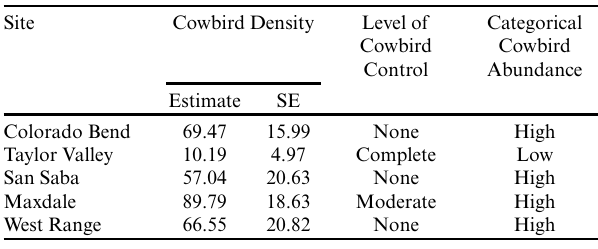
Table 1. Cowbird density (birds/km 2 ), level of cowbird control, and categorical cowbird abundance at Black-capped Vireo breeding sites in central